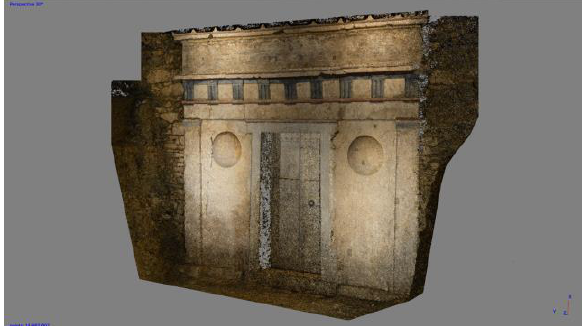
Figure 8. The Tomb of Philip II in Verghina. Cloud of points, detail from the east.